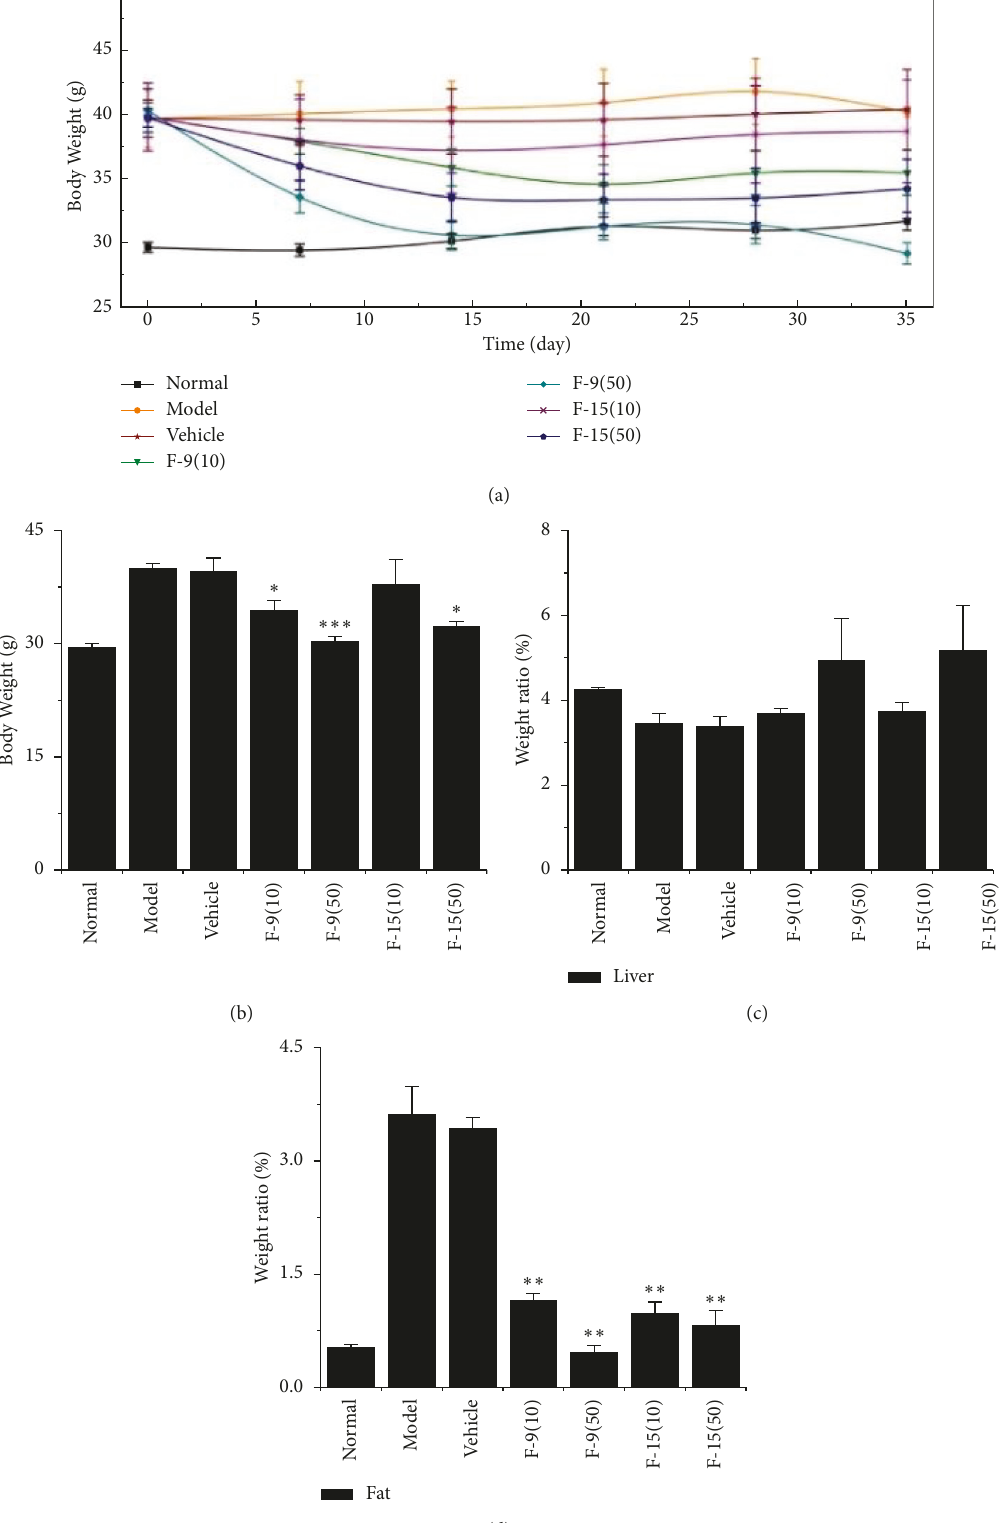
Figure 2: Bodyweight, the ratio of liver weight to bodyweight and the ratio of fat weight to bodyweight were tested. (a) Bodyweight changes in mice at different times. (b) Bodyweight changes in mice in different groups. (c, d) The ratio of liver weight to bodyweight and the ratio of fat weight to bodyweight were detected